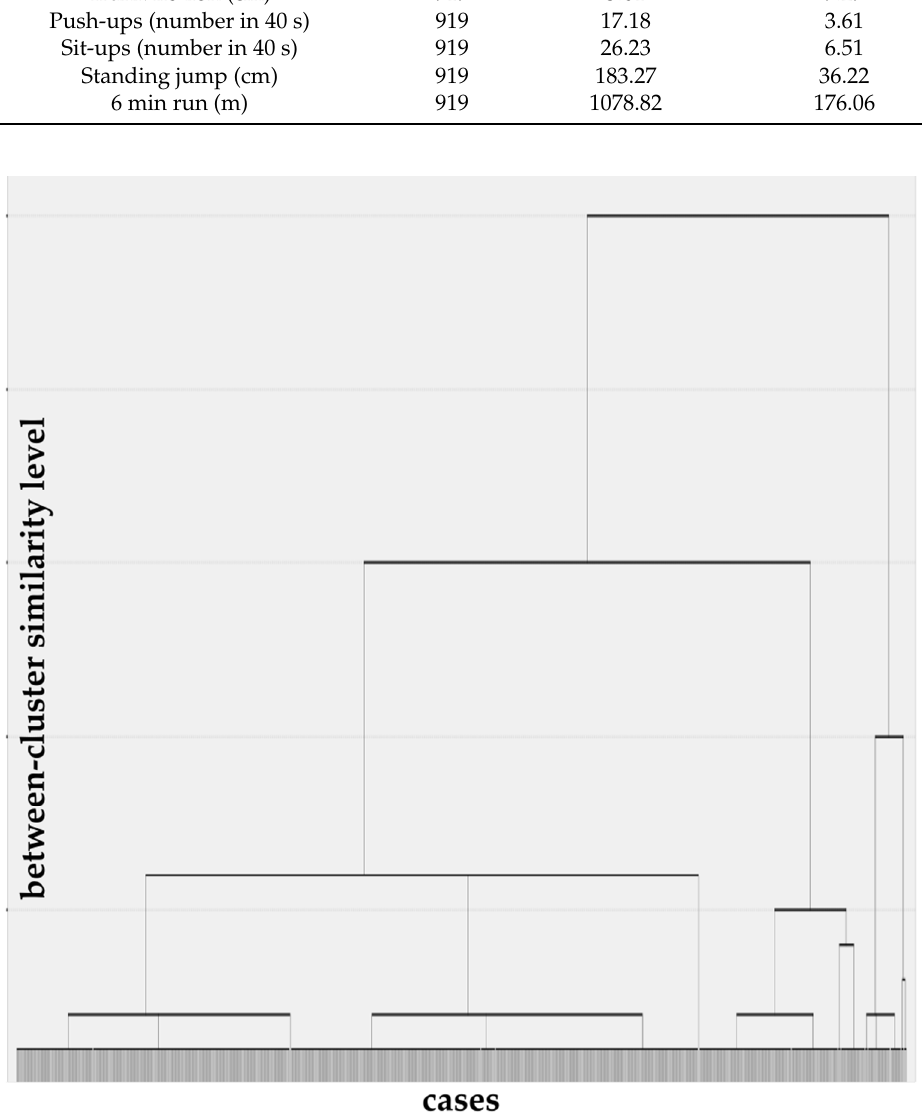
Figure 1. Cluster tree for the physical fitness subtests.